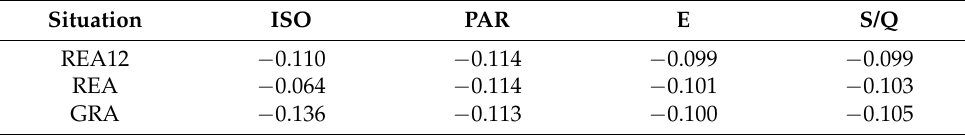
Table 8. The O 3 response rates with its driving factors considering isoprene’s role.